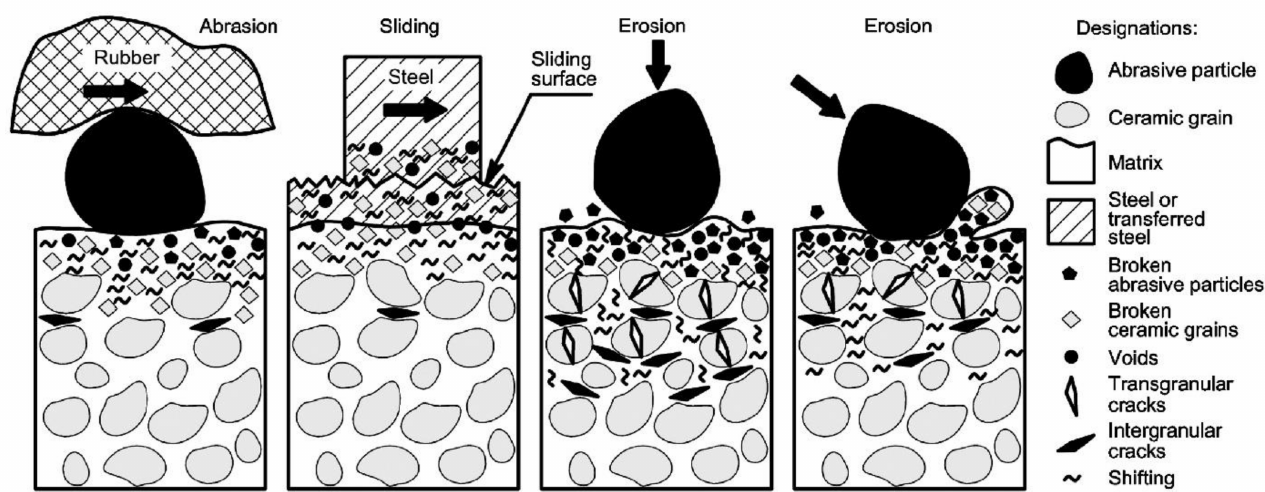
Figure 8. Features of cermet surface transformation under abrasive, sliding and erosive wear [60]. The wear mechanism of WC-Co hardmetals and cermets may be somewhat